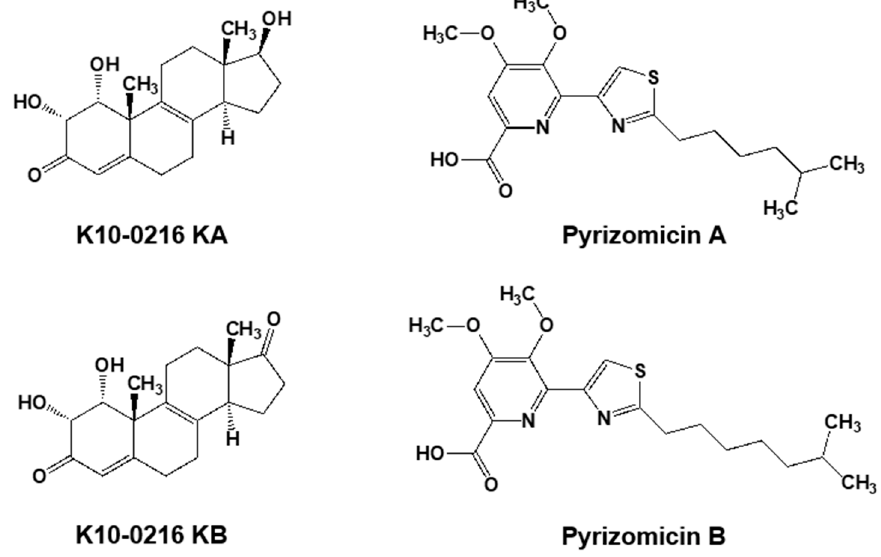
Figure 5. Two steroid compounds (K10-0216 KA and KB) and two compounds containing thiazole and pyridine (pyrizomicin A and B) from L. aerocolonigenes K10-0216 (Figure 4a).